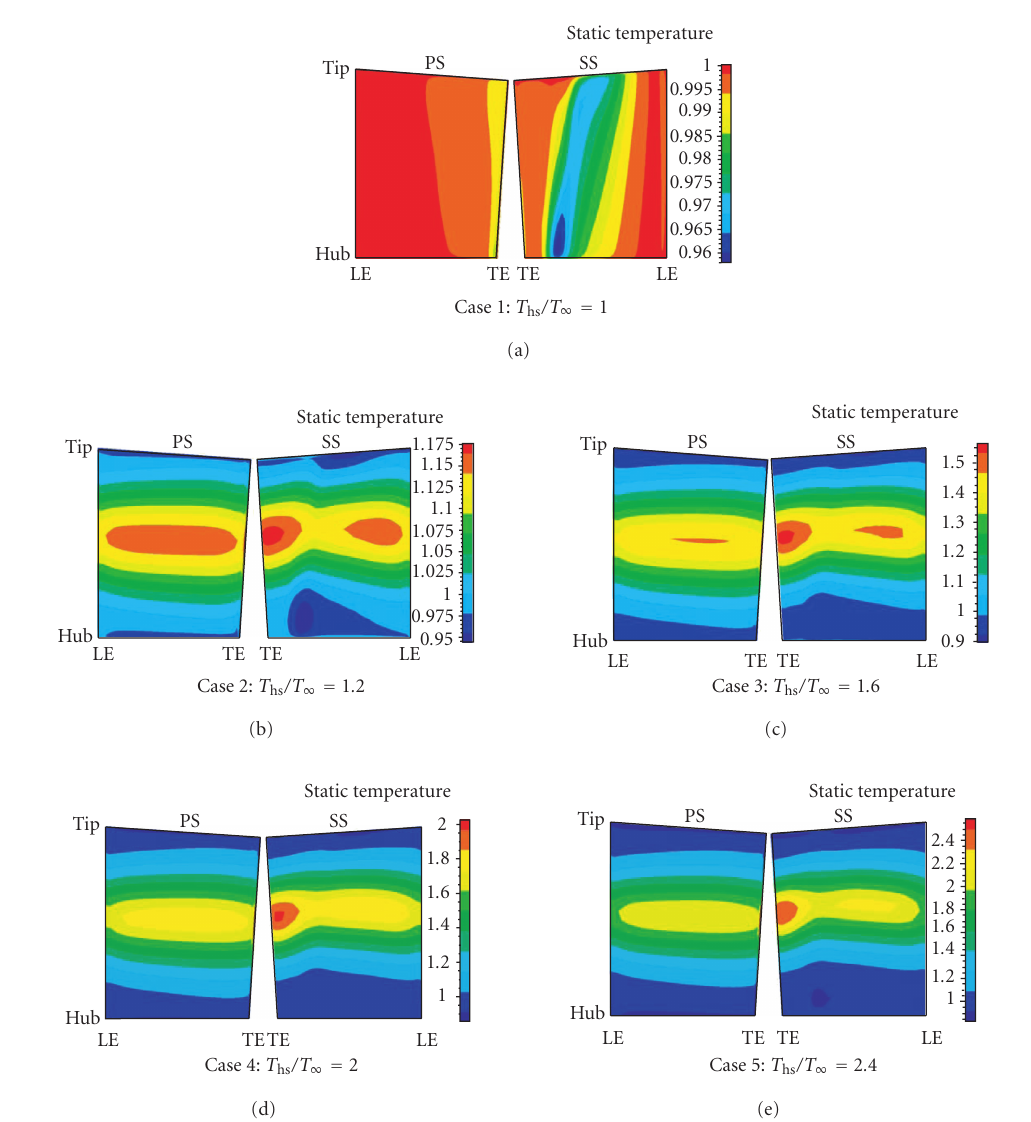
Figure 11: Time-averaged static temperature contours on the HPT